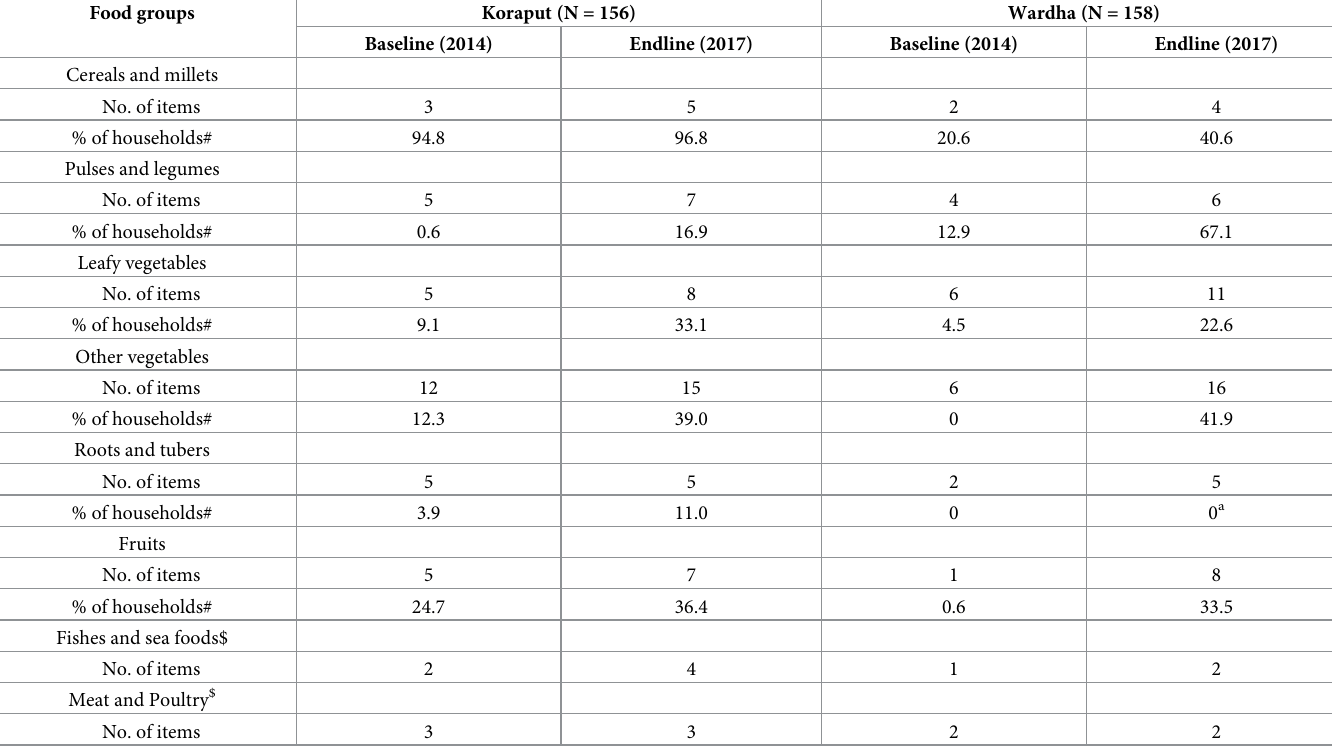
Table 7. Comparison of no. of items consumed under each food group and percentage of households consuming � 70% of RDI � . Food groups Koraput (N =